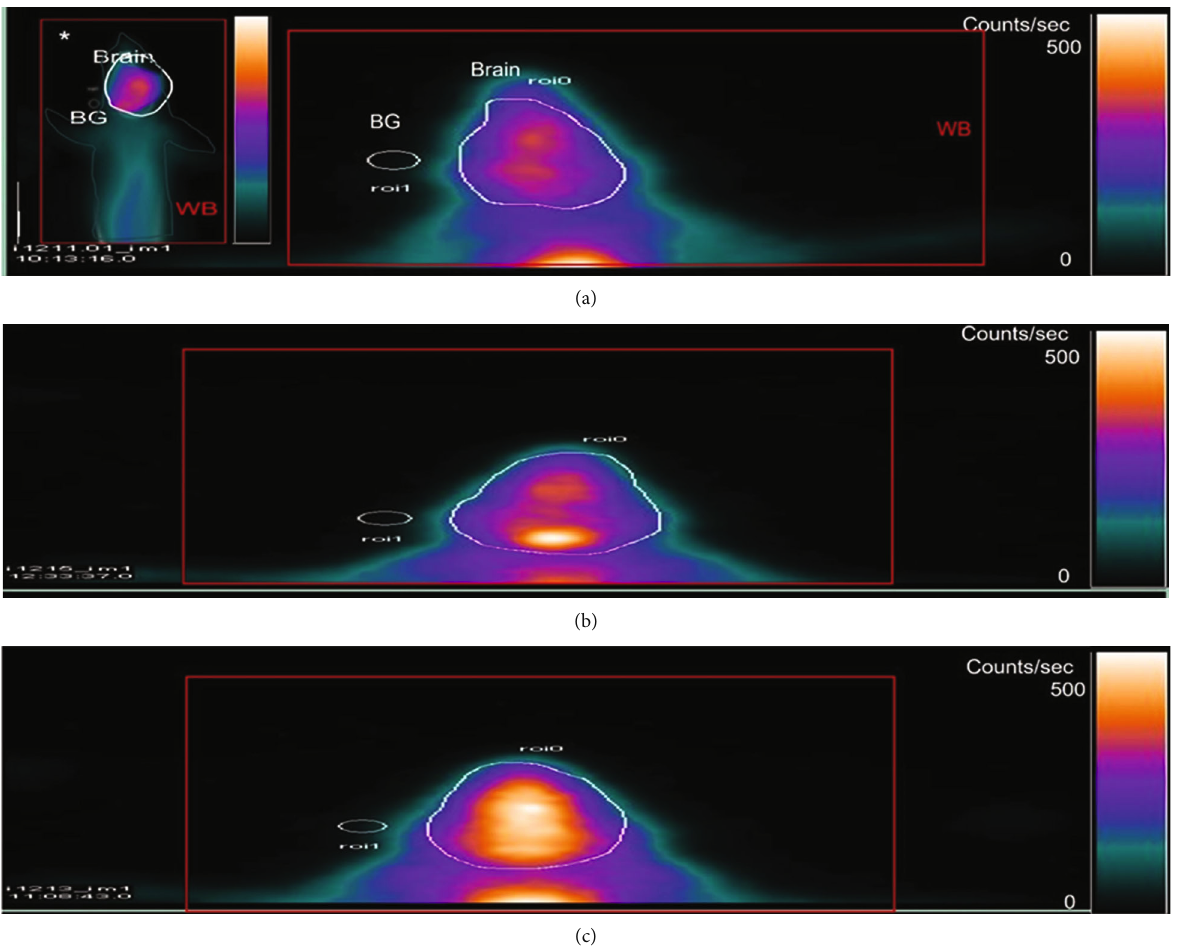
Figure 1: 99m Tc-HMPAO (brain) male rat imaging. Composite 0 – 60min images and regions of interest (ROIs) used as (a) receiving 0 mg/ kg 13-RA as the control (C), (b) receiving 0.3mg/kg 13-RA as the low-dose group (L), and (c) receiving 0.5mg/kg 13-RA as the high-dose group (H). Brain ROI: BG: background and WB: whole body ( ∗ whole body of rat